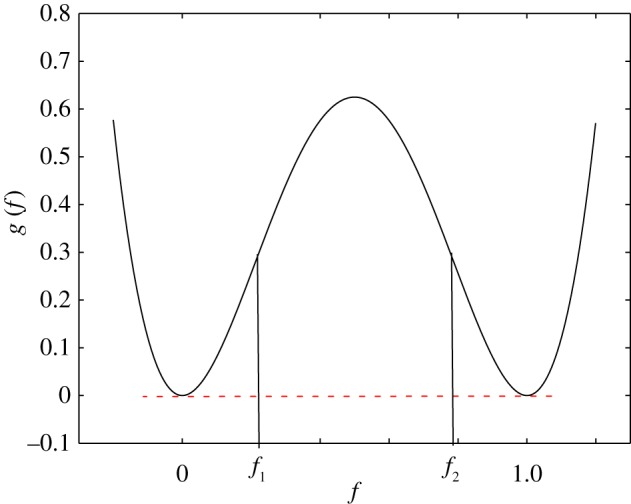
Homogeneous free energy of mixing.